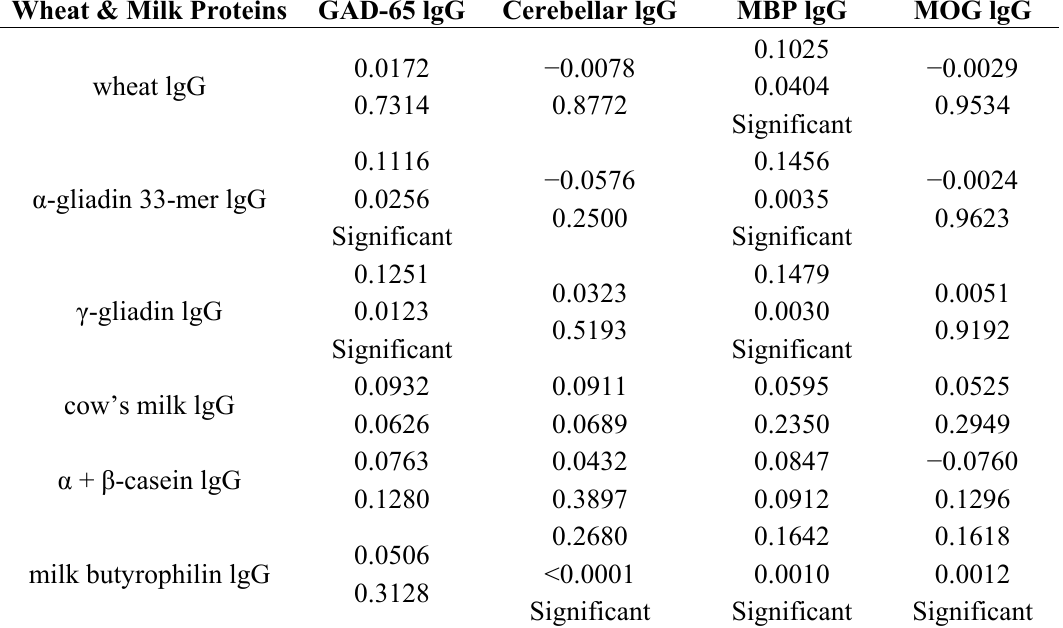
Table 1. Results of the simple linear regression between lgG isotypes of food proteins and the brain proteins. The first number in each cell presents corresponding Pearson’s correlation coefficient and the second number presents its p -value. Small p -value (less than 0.05) indicates statistical significance. Note that R 2 values of these regressions are the squares of the Pearson’s correlation